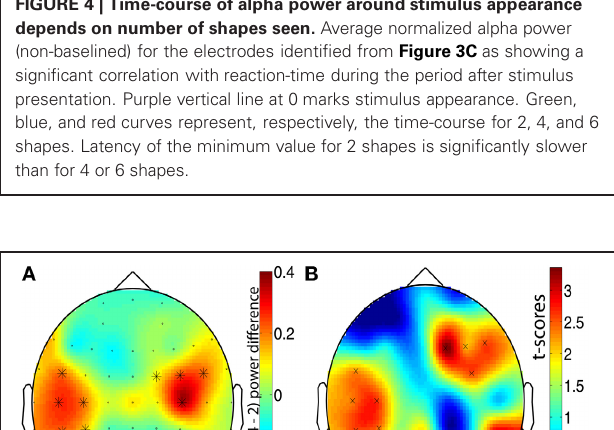
central-parietal region and the other located in the right central- frontal region (see Figure 5